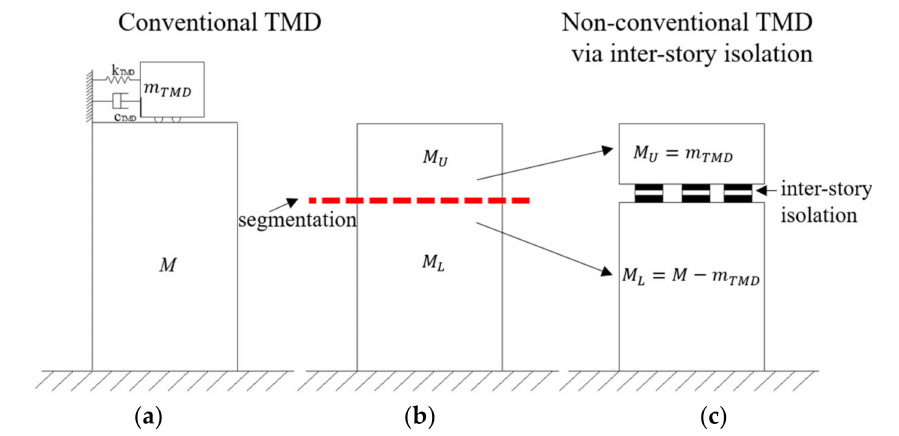
Figure 1. ( a ) Structure with conventional TMD, ( b ) segmented structure, ( c ) structure with non-conventional TMD implemented via inter-story isolation. Red dotted line indicates structural